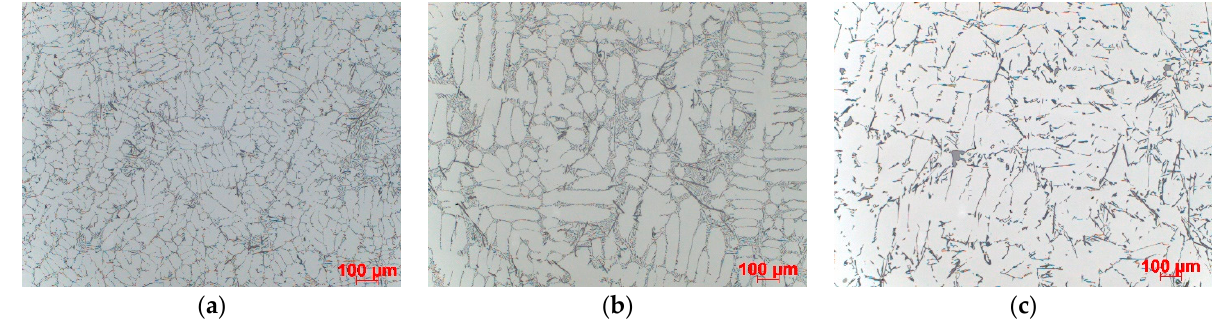
Figure 7. Dispersion of dendritic structure in casting made in Sand No. 4, etched with HF, 100 × magnification: ( a ) die, ( b ) ablation, ( c ) sand mould. Table 2. SDAS, µ m (50 × magnification, oriented